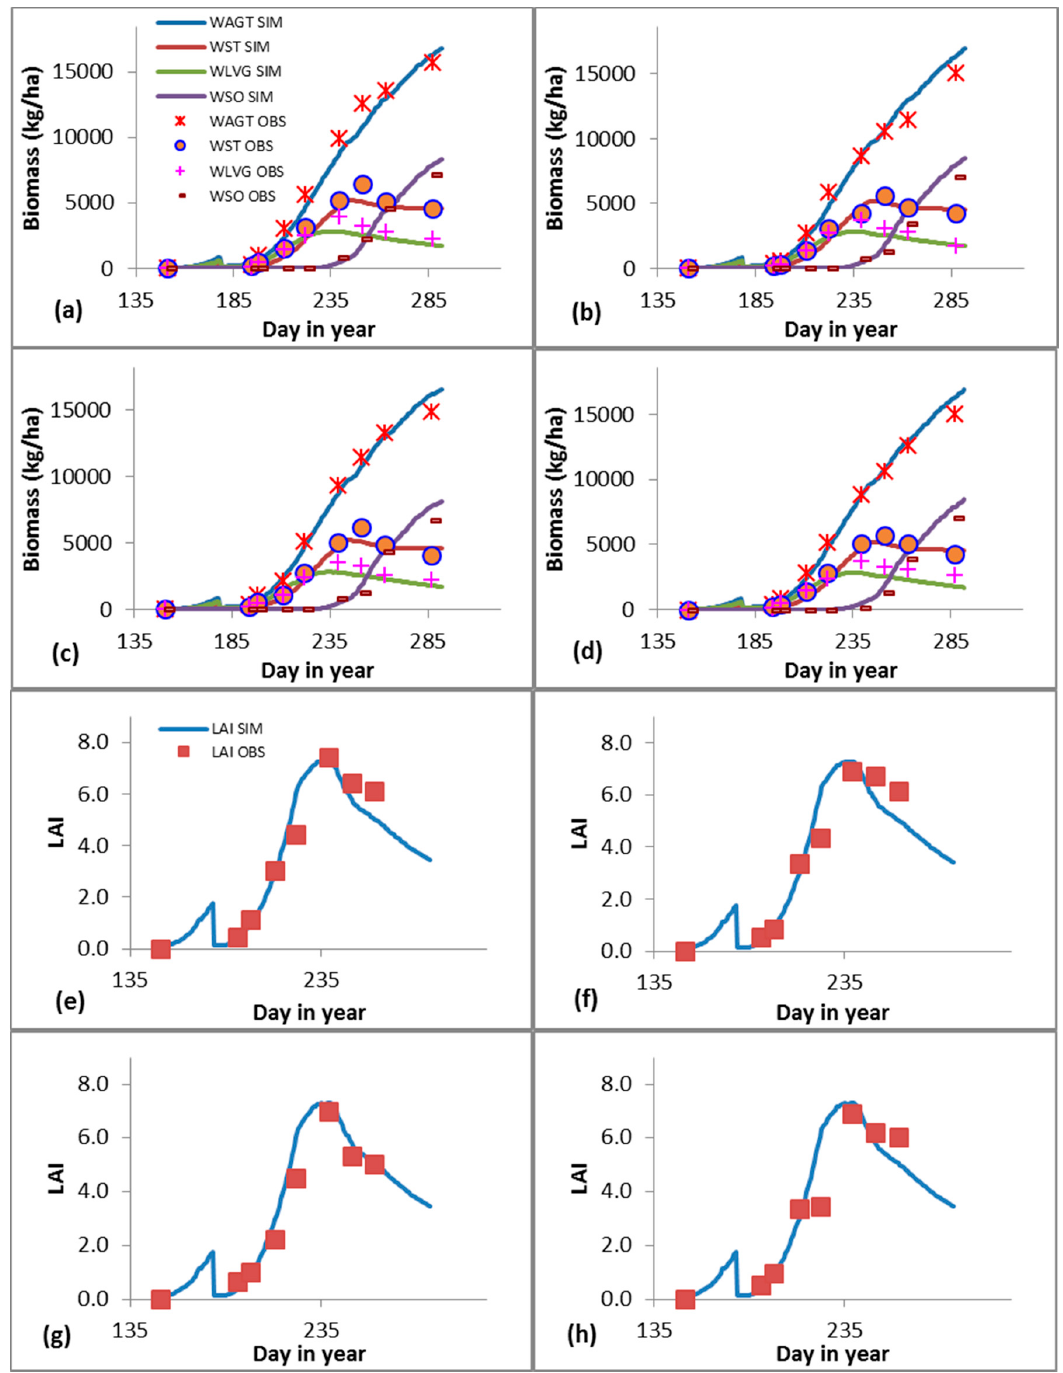
Figure 1. Simulated and observed total biomass (WAGT), green leaves (WLVG), stems (WST), storage organs/panicles (WSO) are presented in ( a , b , c , d ) and leaf area index (LAI) is presented in ( e , f , g , h ), for calibration period 2007, in Kunshan, Nanjing, China.